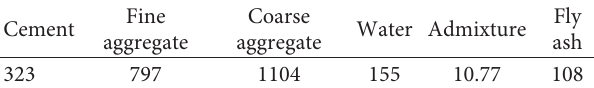
Figure 1: Computation program flowchart of thermohydromechanical combined Table 1: Mix proportion of concrete (kg/m 3 ).